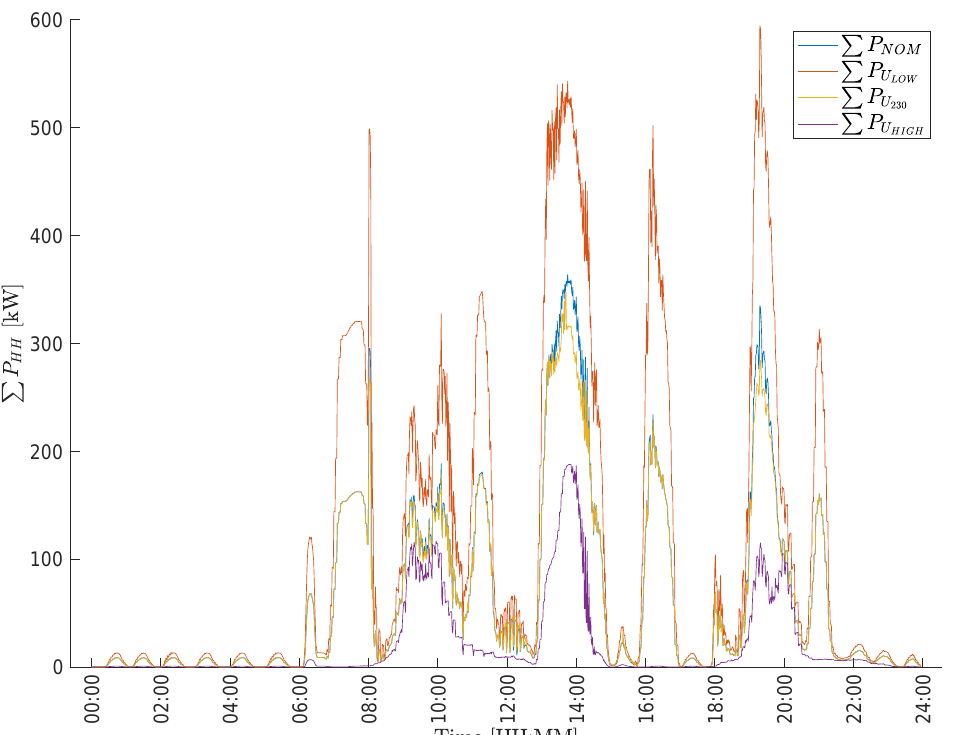
Figure 12. Energy consumption levels for different voltage